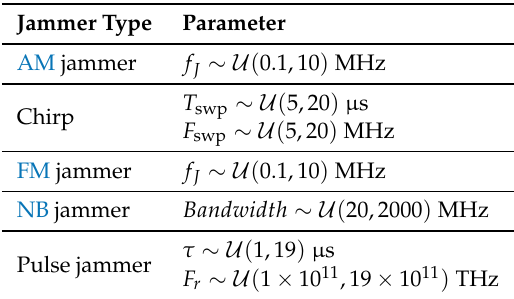
Table 1. Jammer parameters’